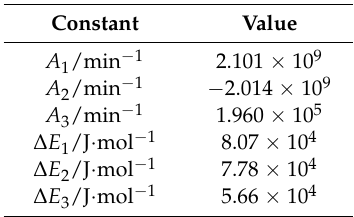
Table 2. Curing constants for 3501-6 epoxy resin